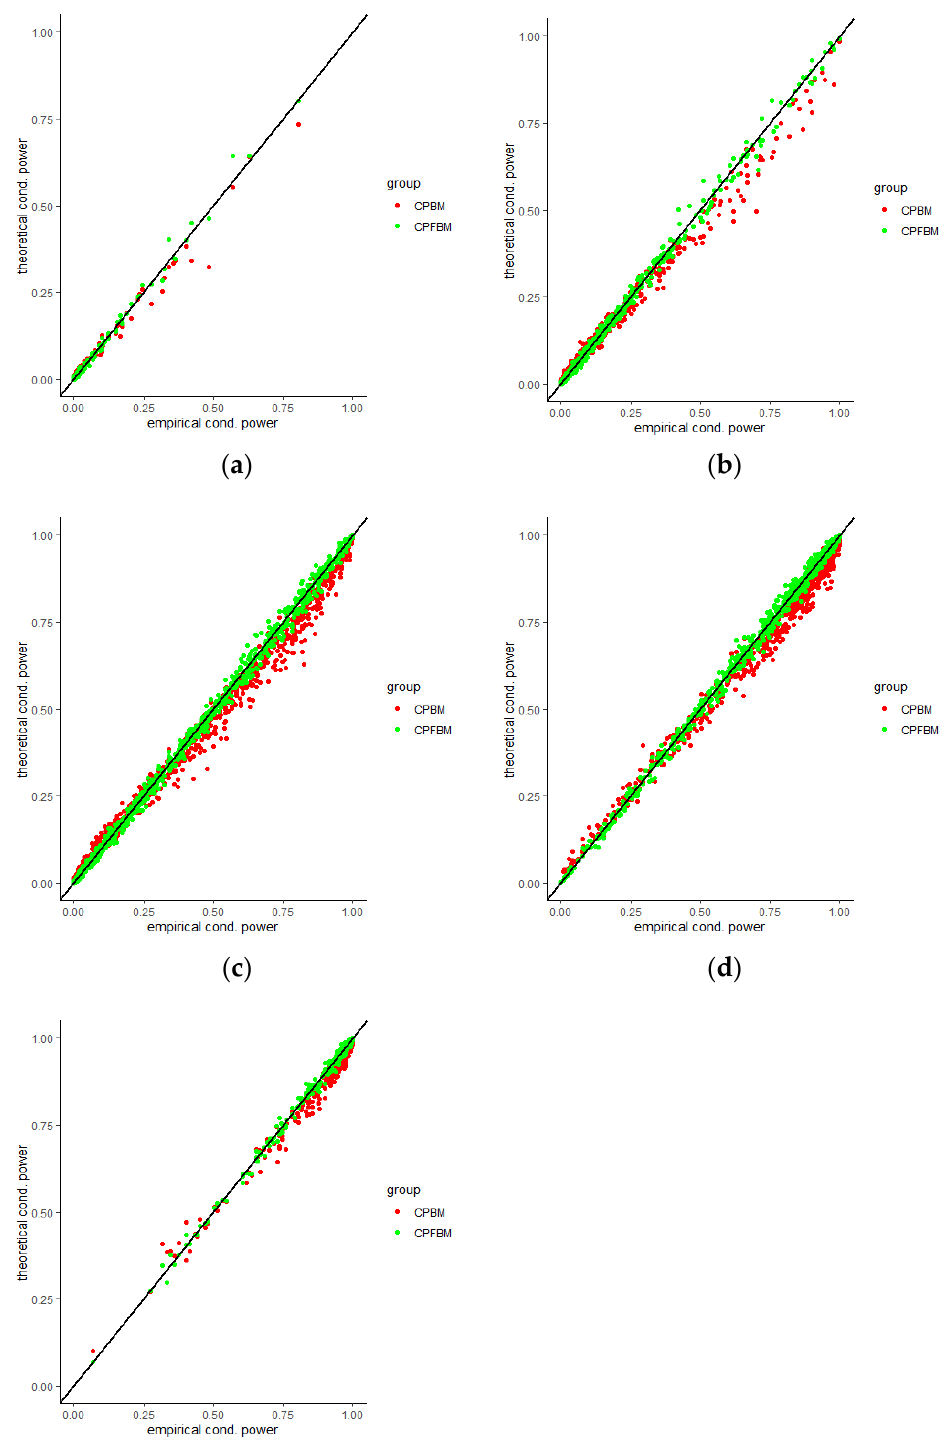
Figure 9. Scatter plots for conditional power under misspecification scenarios (SPB design) showing two discrete covariates with different drift parameters 𝜃 : ( a ) 𝜃 = 0; ( b ) 𝜃 = 0.5; ( c ) 𝜃 = 1; ( d ) 𝜃 = 1.5; ( e ) 𝜃 = 2.